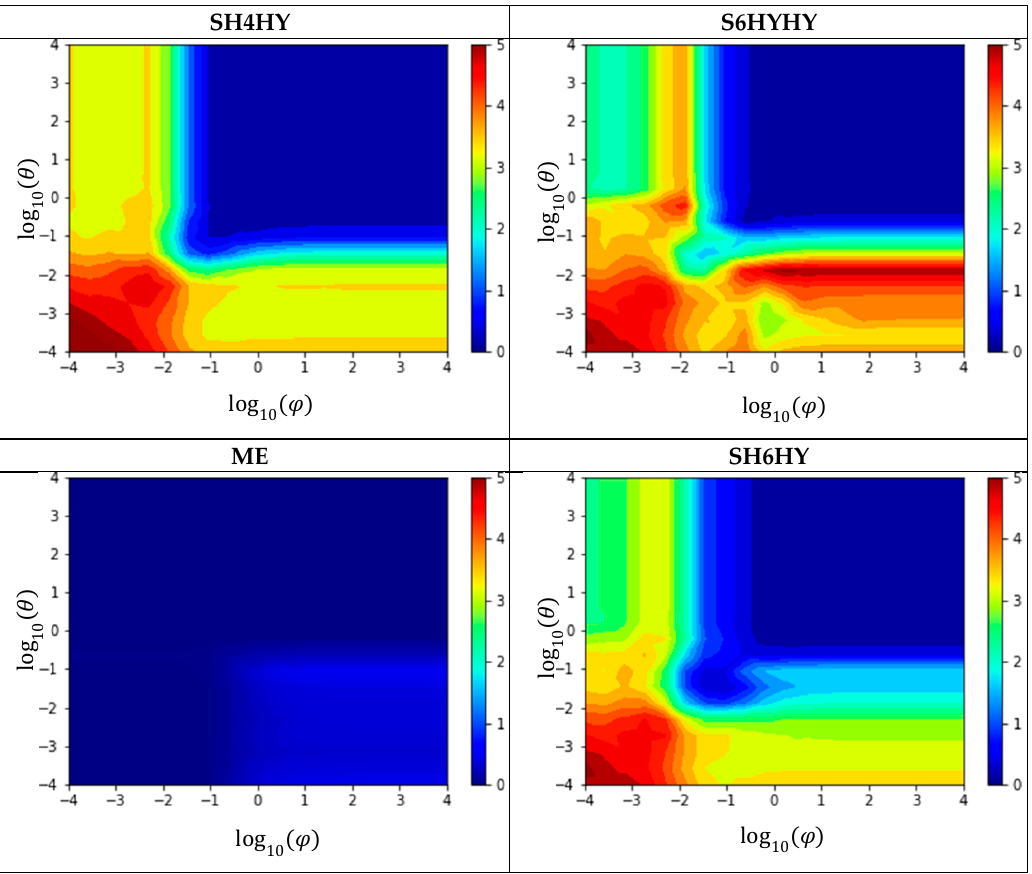
Figure 10. Color plot of the Kullback–Leibner distance in dependency of covariance (SH4HY, SH6HY, SH6HYHY, and ME).